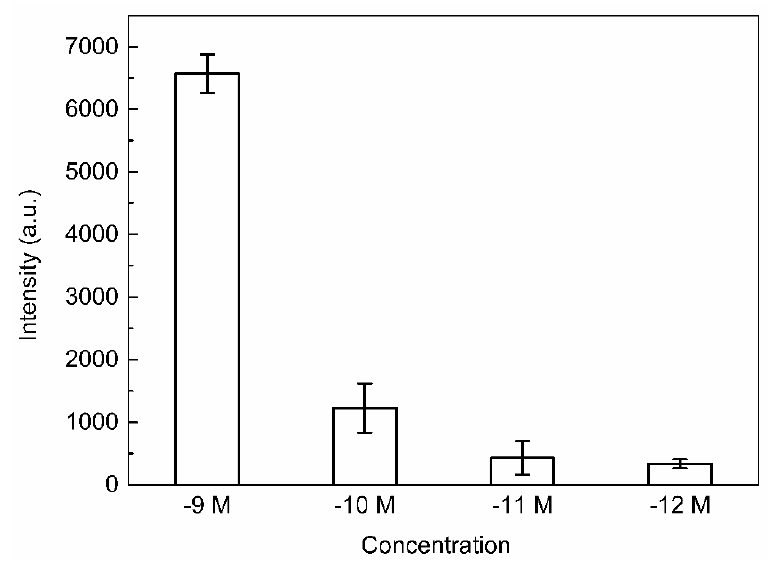
Figure 9. The histogram with errors of the average peak of R6G solution (ranging from 10 − 9 M to 10 − 12 M) at 611 cm − 1 .